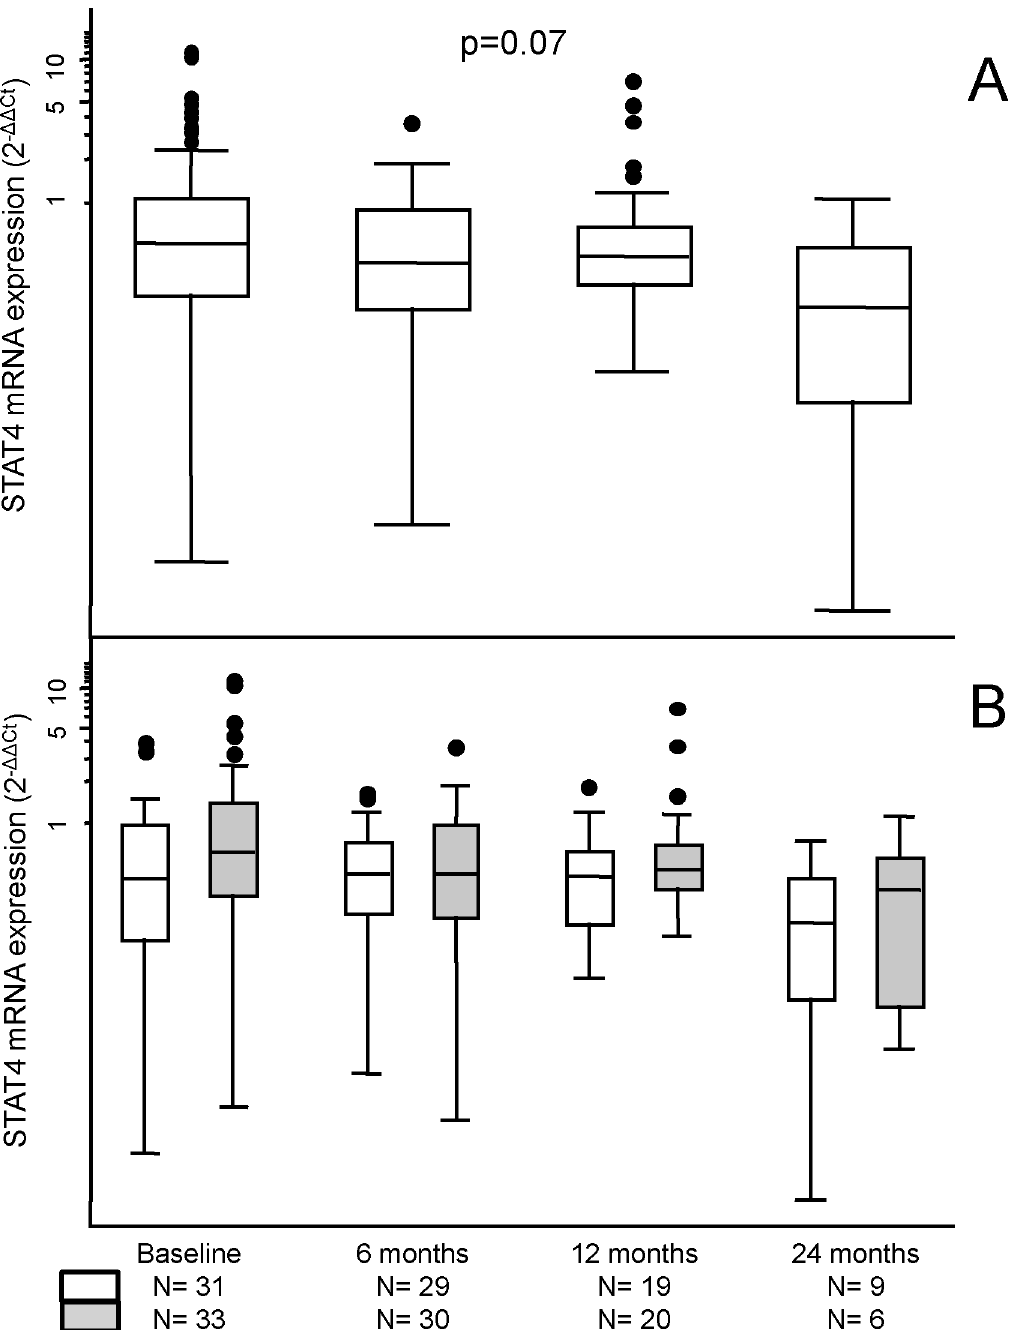
Fig 1. Effect of rs7574865 polymorphism in the STAT4 mRNA levels of patients with early arthritis. (A) Expression levels of STAT4 mRNA during follow-up. Significance level was determined through the Cuzic ’ s nonparametric test for trend across ordered groups. Statistical significance was considered p < 0.05. (B) Data are clustered according to the genotype of rs7574865 in STAT4 , homozygote GG (white boxes) versus presence of the T allele (gray boxes), and visits during follow-up. Data are presented as the interquartile range (p75 upper edge, p25 lower edge, p50 midline), p95 (line above the box), and p5 (line below the box) of relative STAT4 mRNA expression (2 - ΔΔ Ct ). Dots represent the